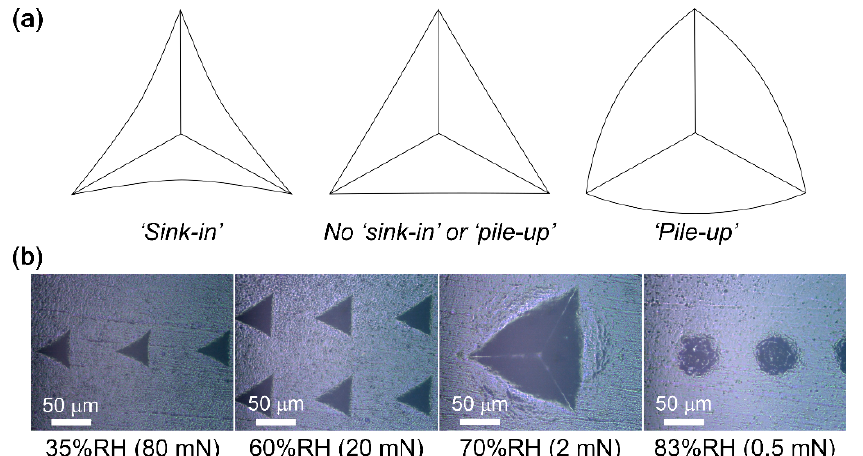
Figure 6. Residual imprints of a Berkovich indenter showing different degrees of ‘sink-in’ and ‘pile-up’; ( a ) schematic diagrams and ( b ) microscopic images of imprints recorded after indenting Winsor & Newton ultramarine oil paint at different relative humidity levels (note differences in maximum load applied at different humidity levels).